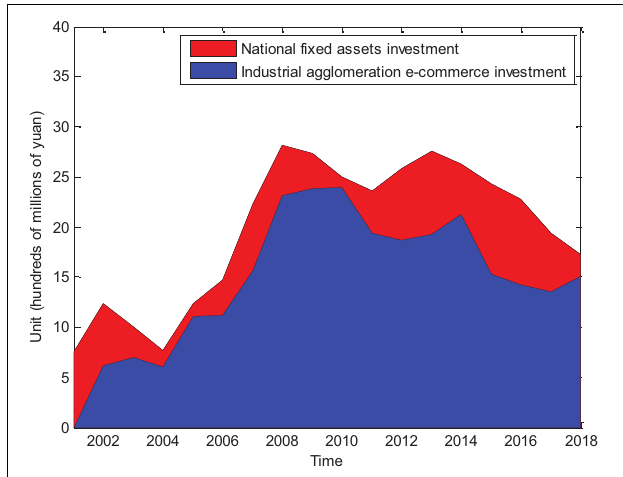
FIGURE 5 | Changes in national fixed asset investment and industrial agglomeration e-commerce investment from 2001 to 2018.